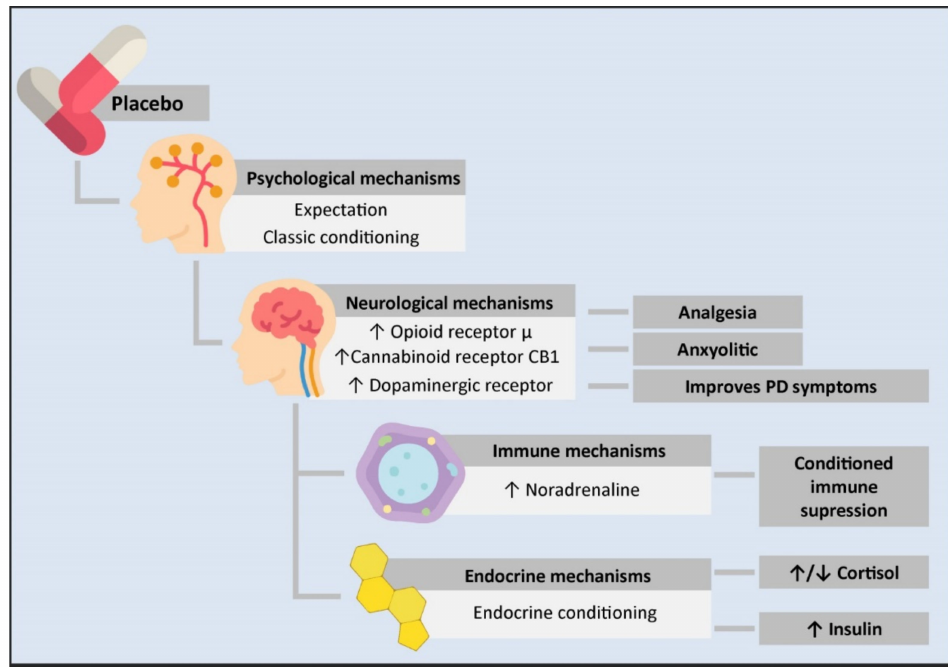
Figure 1. Psycho-neuro-endocrine-immune mechanisms of the placebo effect. The administration of a placebo generates a series of psychological and physiological changes in an individual. From the psychological standpoint, it can cause expectations or work as a conditioned stimulus. This is transmitted at the neurological level through an increase in the neurotransmission of µ